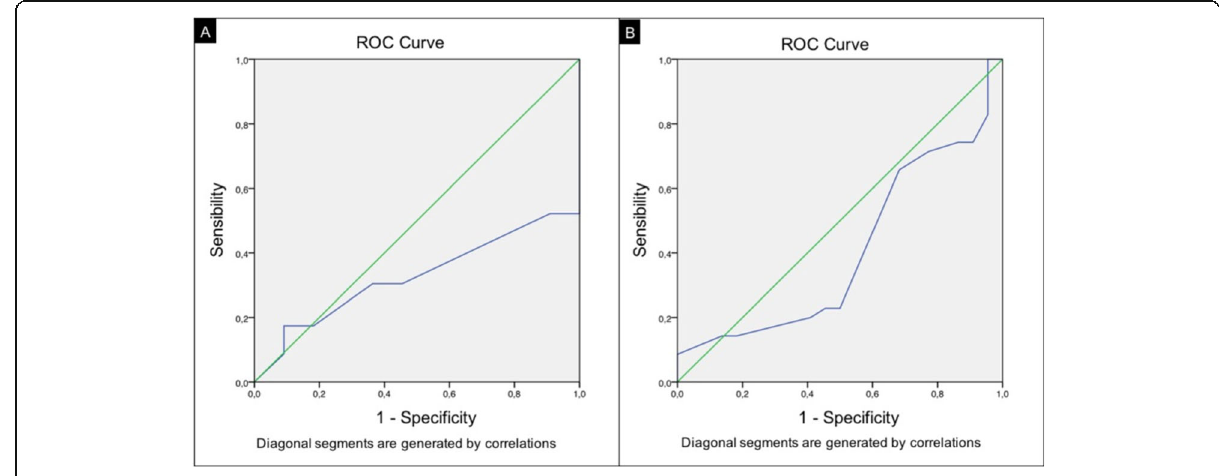
Fig. 3 ROC curve analysis for MVP-3 ( A ) and MVP-5 ( B )